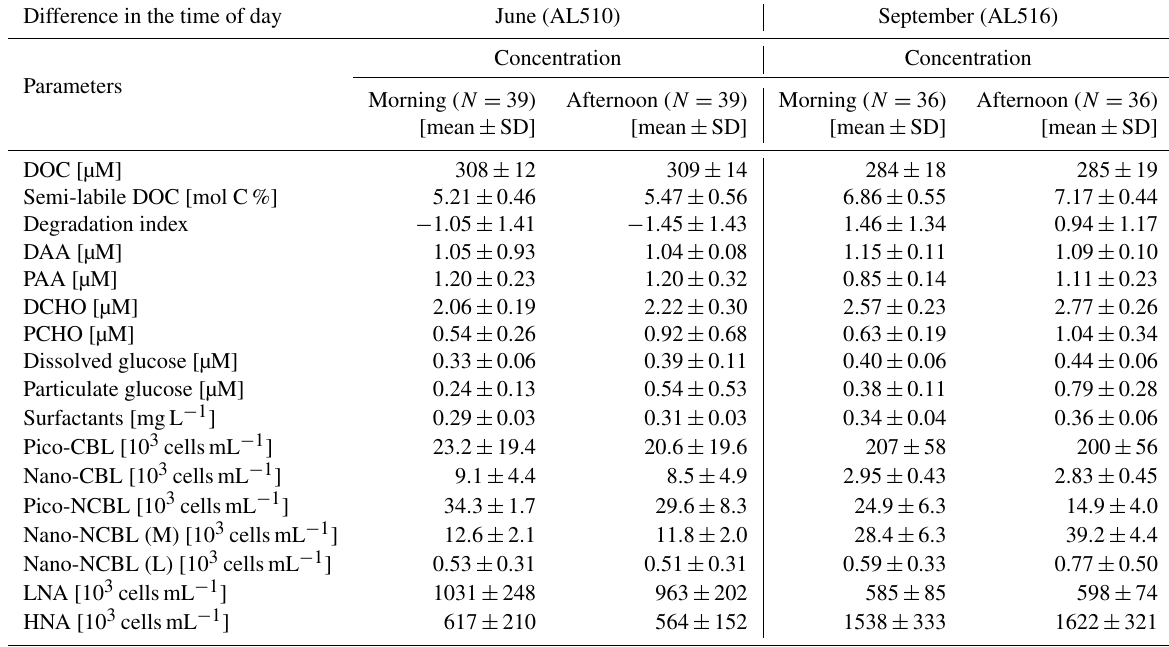
Table A4. Diurnal variation in concentration of seasonal data sets; sea surface microlayer and the underlying water samples are included. Difference in the time of day